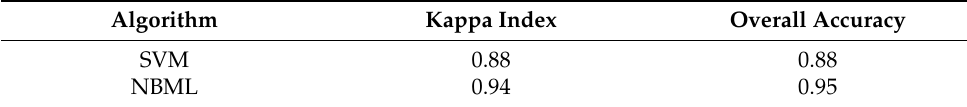
Figure 13. Temperature classification results. ( a ) SVM; ( b ) naïve Bayes. Table 6. Kappa Index and Precision of SVM and NBML.